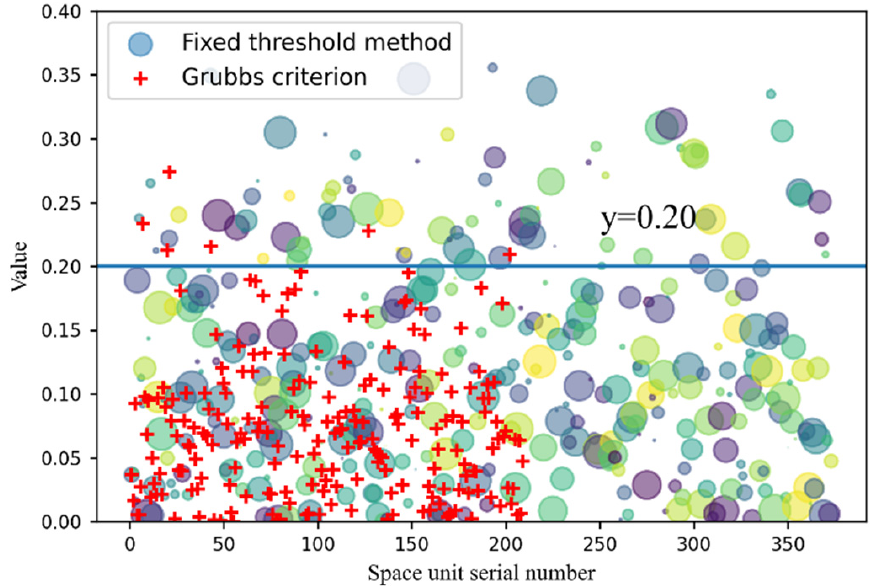
Figure 9. Distribution of the differences between the maximum value and the second largest value of the functional-intensity ratio of mixed-function areas based on the fixed-threshold method and Grubbs criterion.